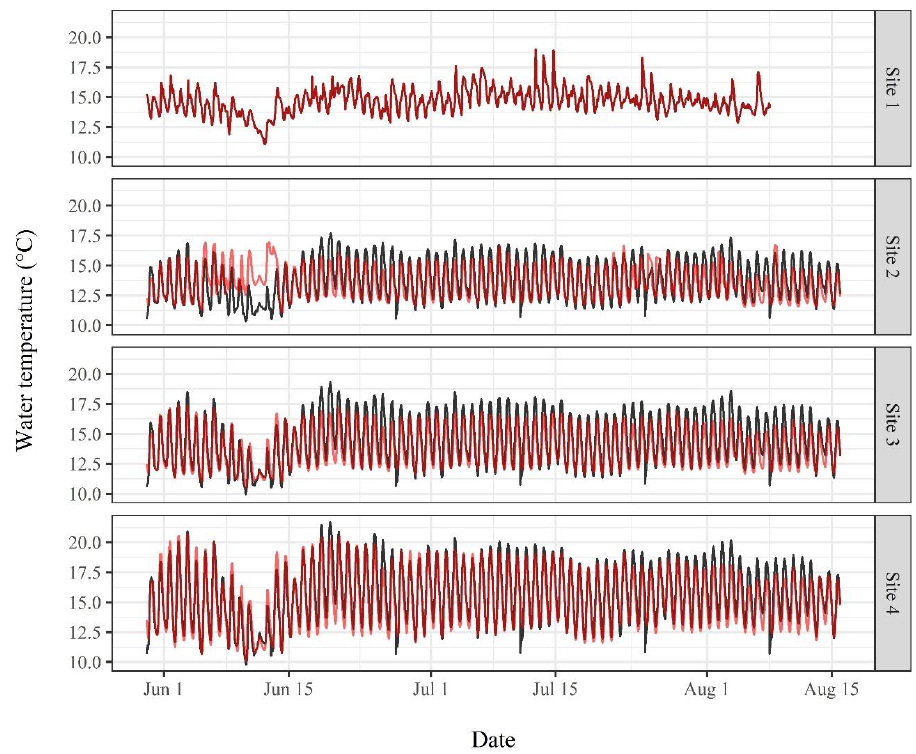
Figure A1. Plots of the modeled (black line) water temperature versus observed (red line) water temperatures for the biweekly canopy growth simulation.